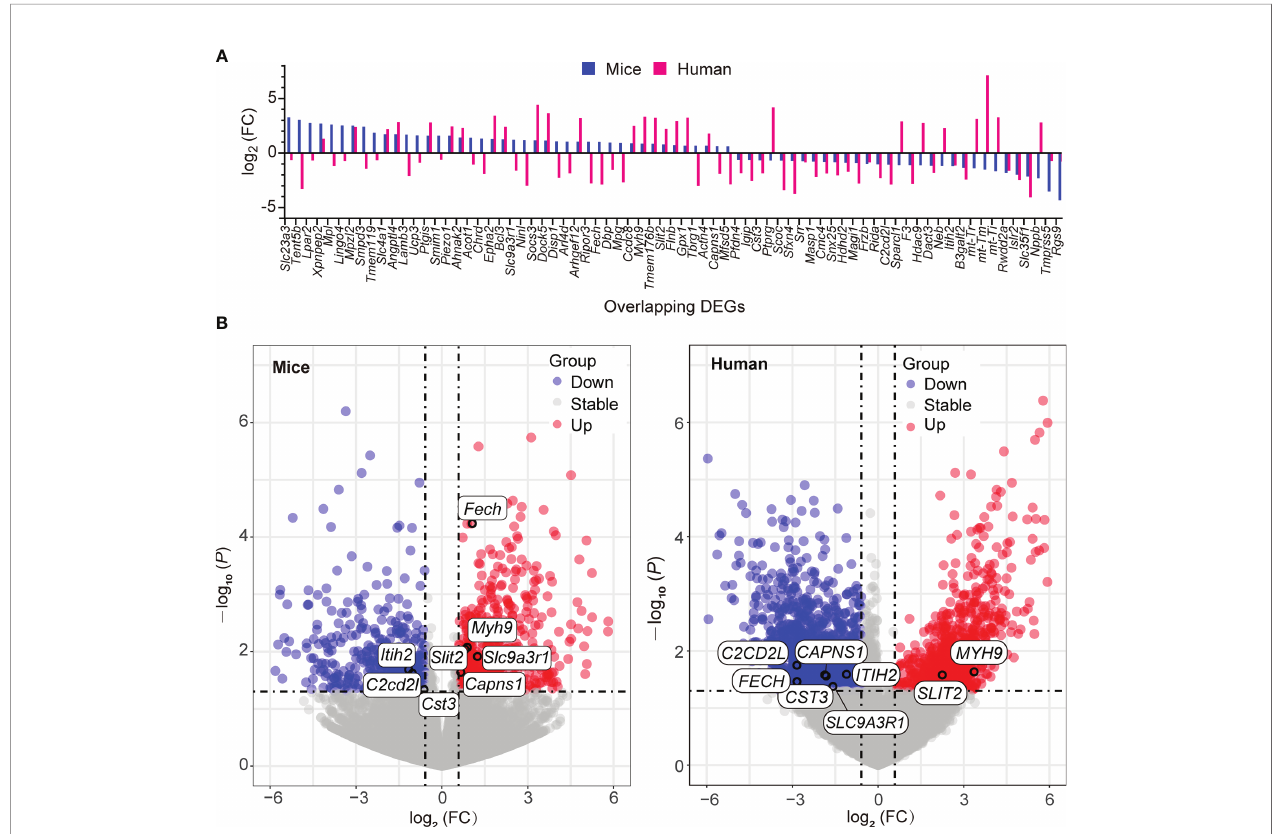
FIGURE 3 | Transcription of the overlapping homologous DEGs with signi fi cance in T2D hearts. (A) Spectrum of the up- and down-regulation levels of the overlapping homologous DEGs in the datasets GSE161931 (mice), GSE150316 vs GSE133054 (human). (B) Distributions of the up- and down-regulated overlapping DEGs among the top-10 GO events in respective volcano